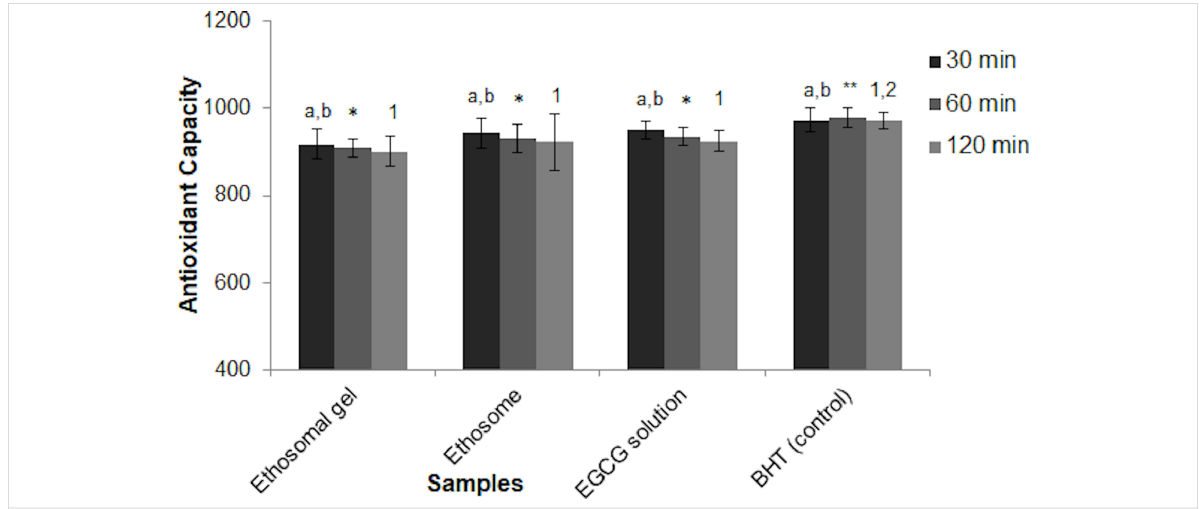
Figure 5: β -Carotene/linoleic acid co-oxidation inhibitory effects of EGCG in different samples [BHT: control group. Values are expressed as mean ± standard deviation, n = 3, bars with the same lowercase letter (a,b), (*,**), and (1,2) are not significantly different ( p >